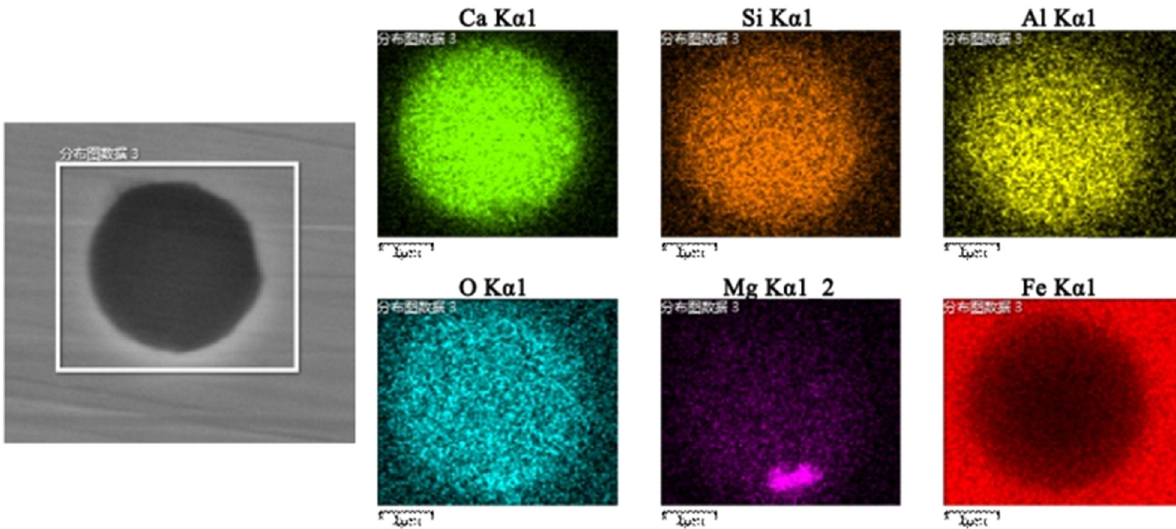
Figure 3: Scanning electron microscopy images and element mappings of the CaO – SiO 2 – Al 2 O 3 - type inclusion formed at the vacuum breaking stage in heavy rail